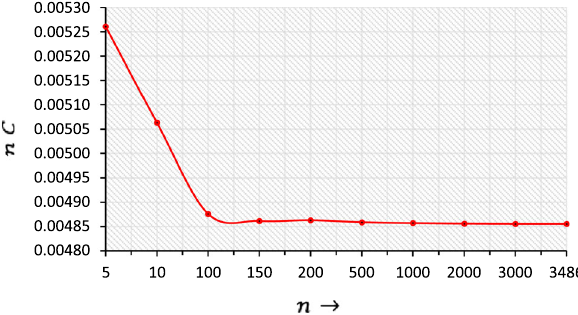
Fig. 11 Variation of n C vs. the integer values of n for LMC X −